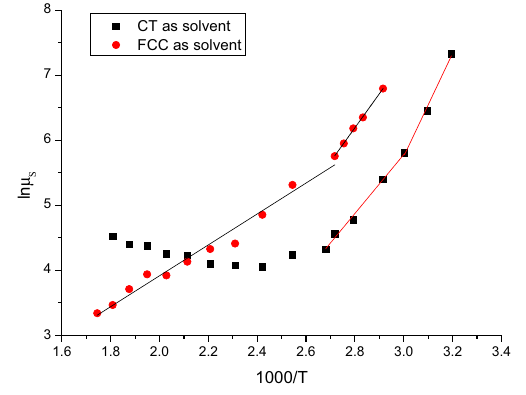
Fig. 5 The relationship curves between ln l s and 1